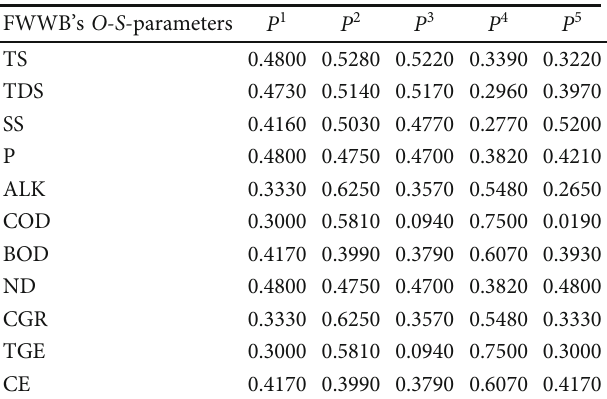
Table 9: Computed weight stabilizes values of S O - S -parameters corresponding to FWWB